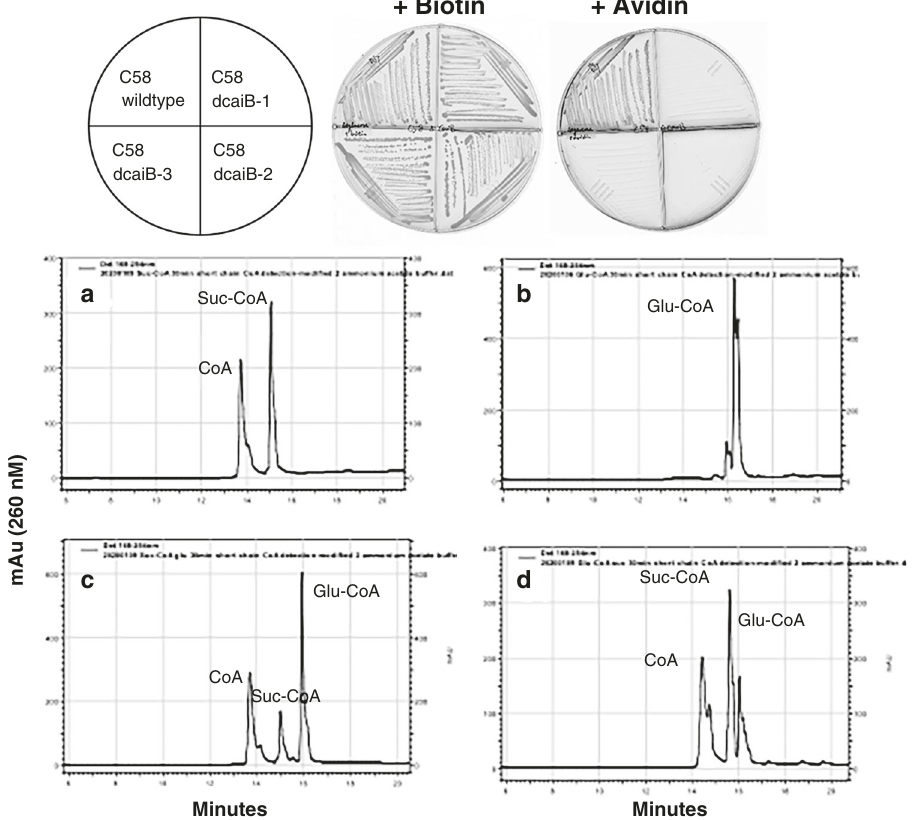
Fig. 9 A. tumefaciens CaiB is essential for biotin synthesis and catalyzes transfer of CoA from succinyl-CoA to glutarate to produce glutaryl-CoA. a Growth of the A. tumefaciens Δ caiB strain on minimal medium containing either biotin or the high-af fi nity biotin binding protein, avidin. Three mutant colonies were streaked. b – e HPLC analyses of CaiB activity by reverse phase HPLC monitored at 260 nm. b succinyl-CoA standard; c glutaryl-CoA standard. d Transfer of CoA from succinyl-CoA to glutarate and e transfer of CoA from glutaryl-CoA to succinate. Note that succinyl-CoA is unstable in the assay and gives rise to free